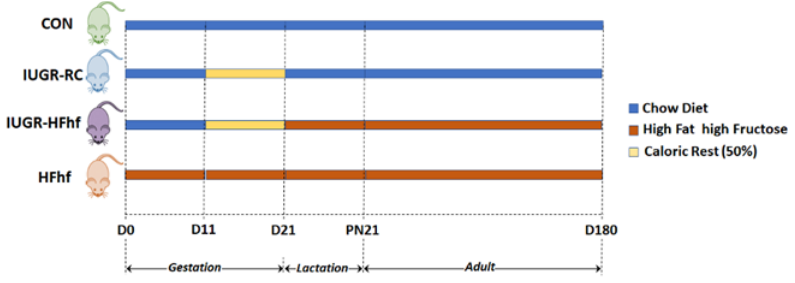
Figure 1. Scheme of the study design, depicting all dietary groups and duration of caloric restriction. For PN2 and PN21 samples 7–10 male and female rats were assigned to each group. For D180 samples 12 – 16 male and female rats were assigned for each group. D = day of life with D0 equaling the day of conception, PN = postnatal, CON = control, IUGR-RC = Intra-uterine growth restriction on a regular chow diet, HFhf = high fat and high fructose diet, IUGR-HFhf = Intra-uterine growth restriction on a high fat high fructose diet. Key: Caloric Rest = Caloric restriction.